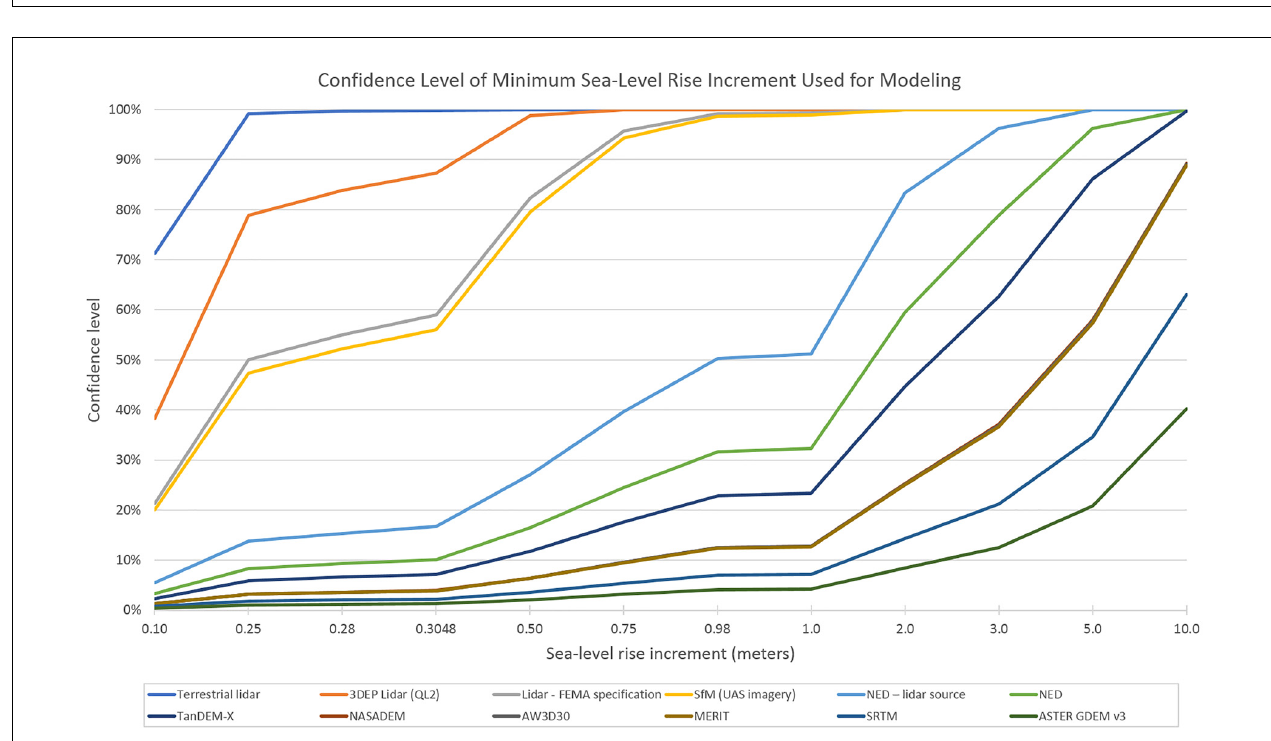
FIGURE 3 | Confidence level for SLRI min for various DEMs and sea-level rise increments. Increments of 0.28 and 0.98 m are included because they represent the minimum and maximum scenarios, respectively, for global sea-level rise by the year 2100 as described in IPCC AR5 (Church et al., 2013). An increment of 0.3048 m is included because it is the equivalent of 1 foot, an increment that is commonly used in local and regional inundation assessments in the U.S.